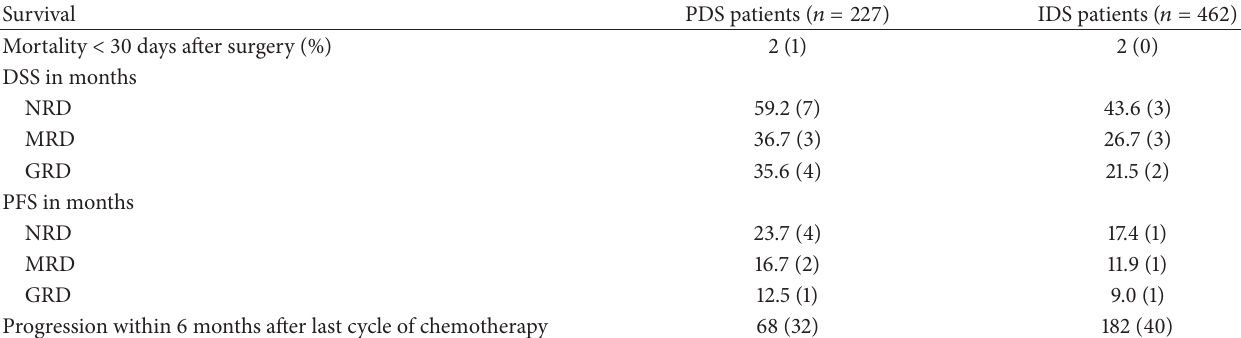
Table 3: Survival outcome according to timing of surgical treatment. Values given are numbers (%) or months (SE) for DSS and PFS. Survival